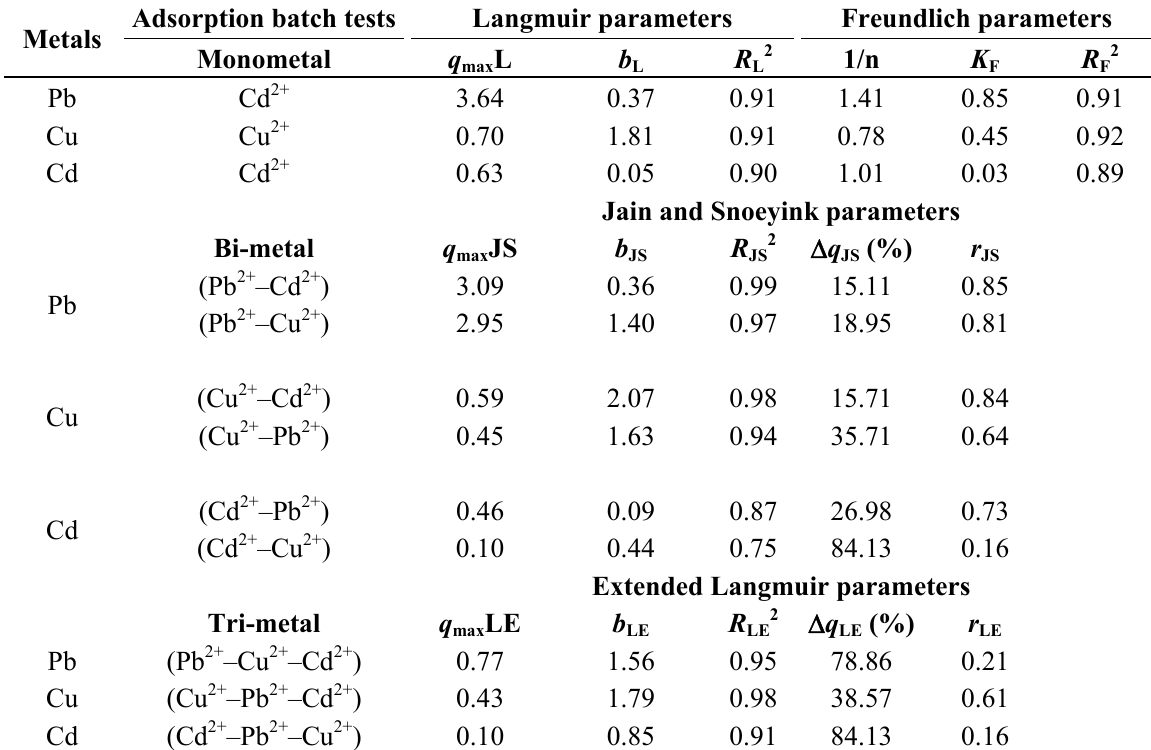
Table 3. Isotherm adsorption parameters for Pb, Cu and Cd in monometal and